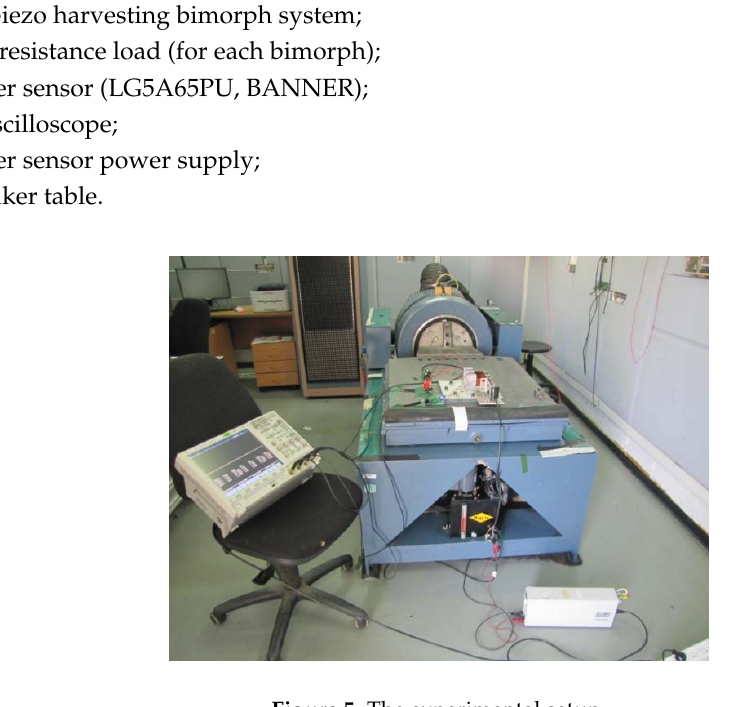
Figure 5. The experimental setup.